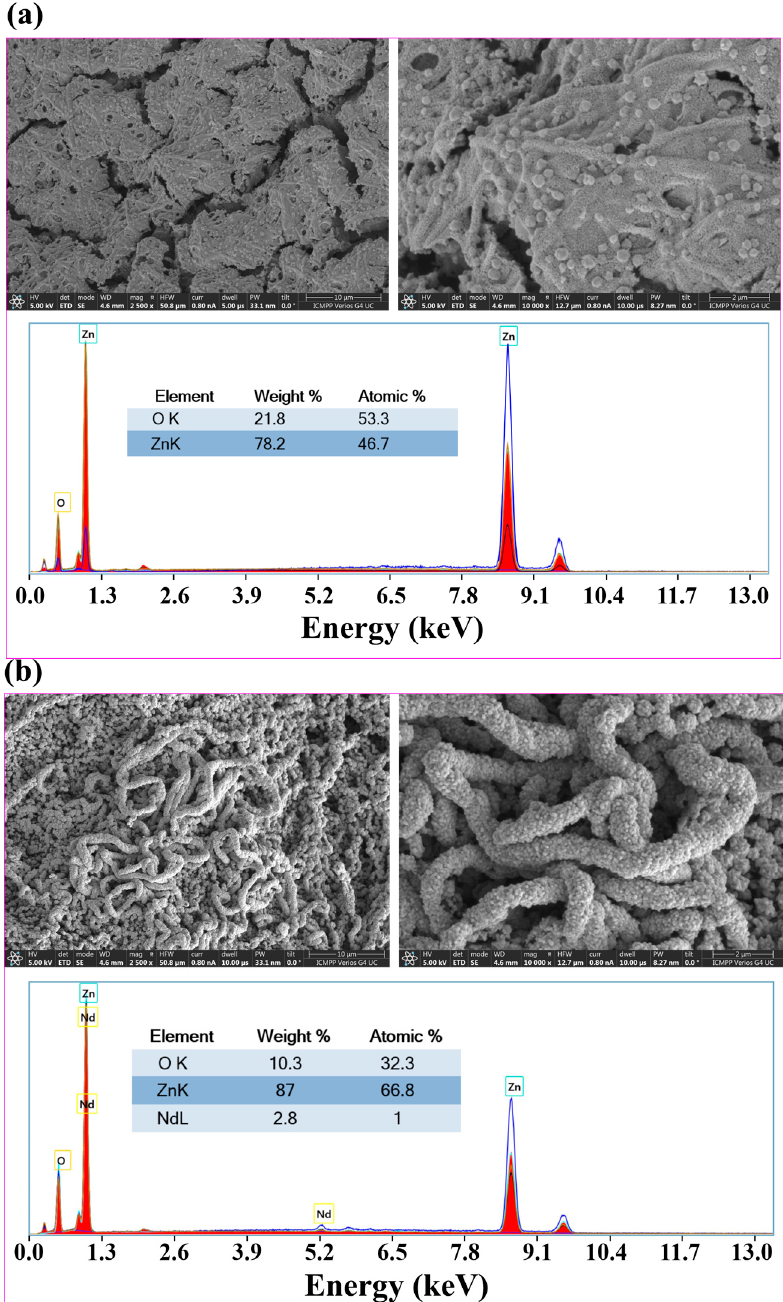
Figure 4. SEM images and EDX spectra of ( a ) undoped ZnO and ( b ) 1% Nd-doped ZnO.